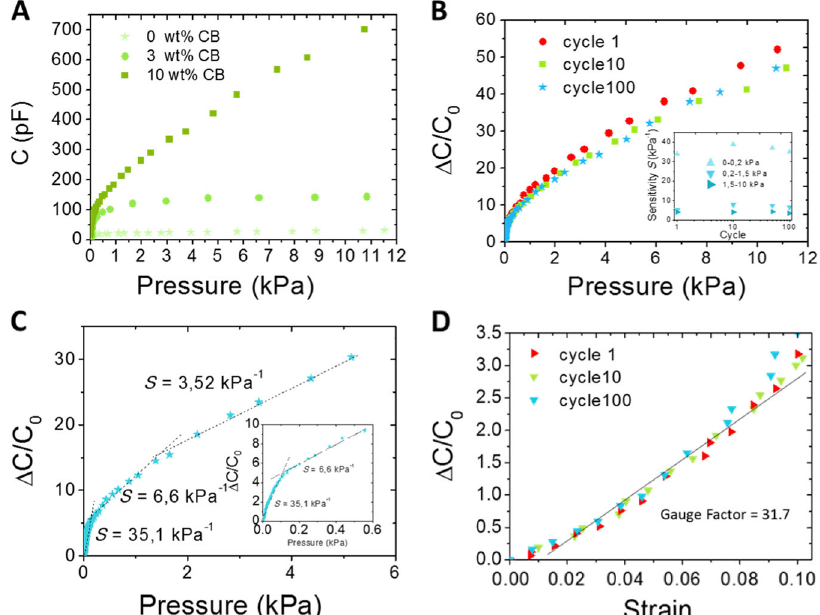
Fig. 3 a Capacitances as a function of the applied pressure for three bilayer materials: 0% CB (stars); 3% CB (circles); 10% CB (squares). b Pressure – response curves for successive loading – unloading cycles of the 10 wt% CB material: 1st cycle (circles), 10th cycle (square), and 100th cycle (stars). Inset: sensitivity S for the three different pressure ranges as a function of cycle number. c Sensitivity measurements S after 100 cycles for three different pressure ranges (10 wt% CB). d Capacitance variations as function of the strain in the bulk domain (Zone III) for successive loading – unloading cycles (red triangles for one cycle, green triangles for ten cycles, and blue triangles for 100